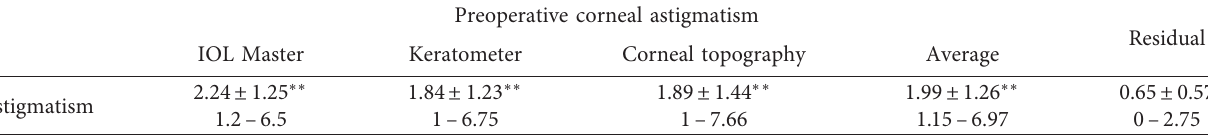
Table 3: Preoperative corneal astigmatism and postoperative residual astigmatism.